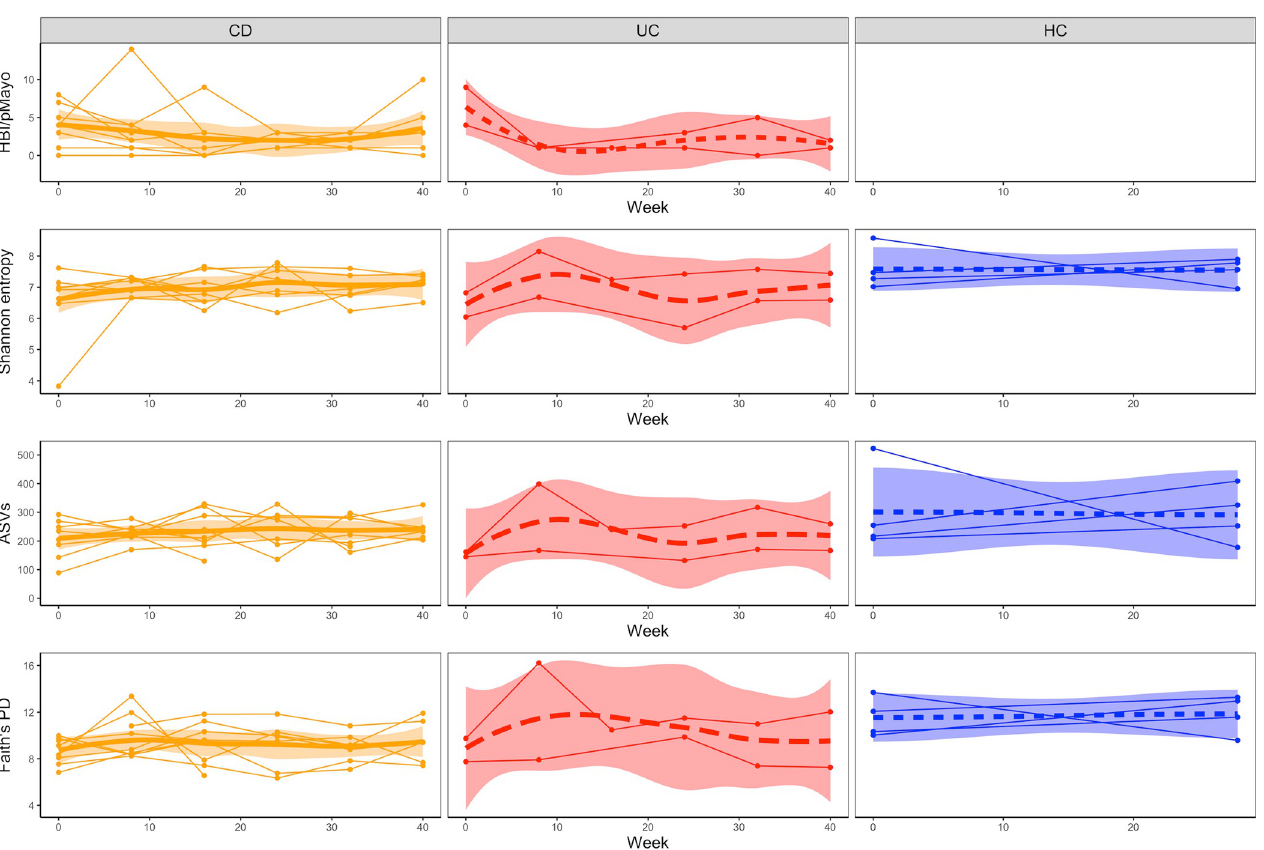
Fig 3. Alpha diversity variation in the stool microbiome of healthy controls and patients with Crohn’s disease and ulcerative colitis during ustekinumab treatment. The line charts show changes in disease activity scores, Shannon entropy, Chao1 diversity estimator, number of observed ASVs and Faith’s phylogenetic diversity over time for patients with Crohn’s disease, ulcerative colitis, and healthy controls. Each line represents one individual, the bold lines represent locally weighted regression with a confidence interval fill. (HBI) Harvey-Bradshaw Index, (pMayo) partial Mayo score, (PD) phylogenetic